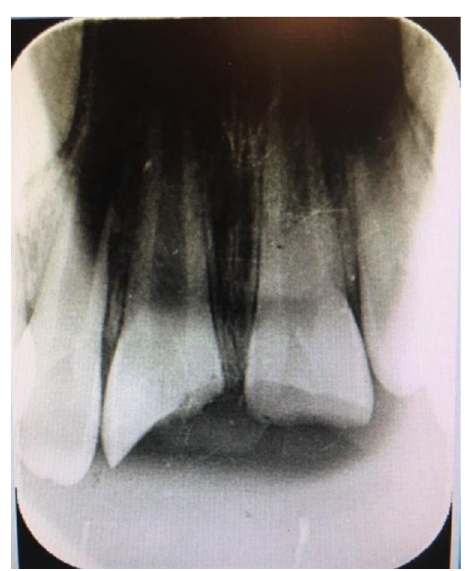
Figure 2: Radiographic